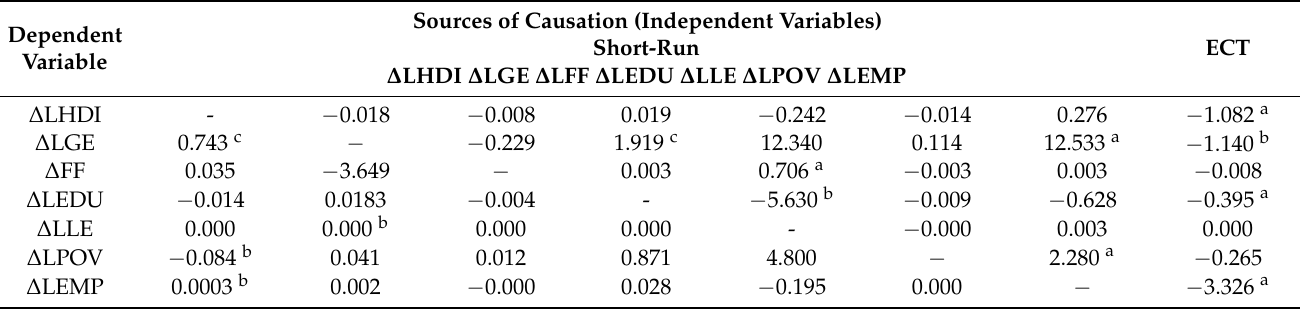
Table 8. Panel Granger causality